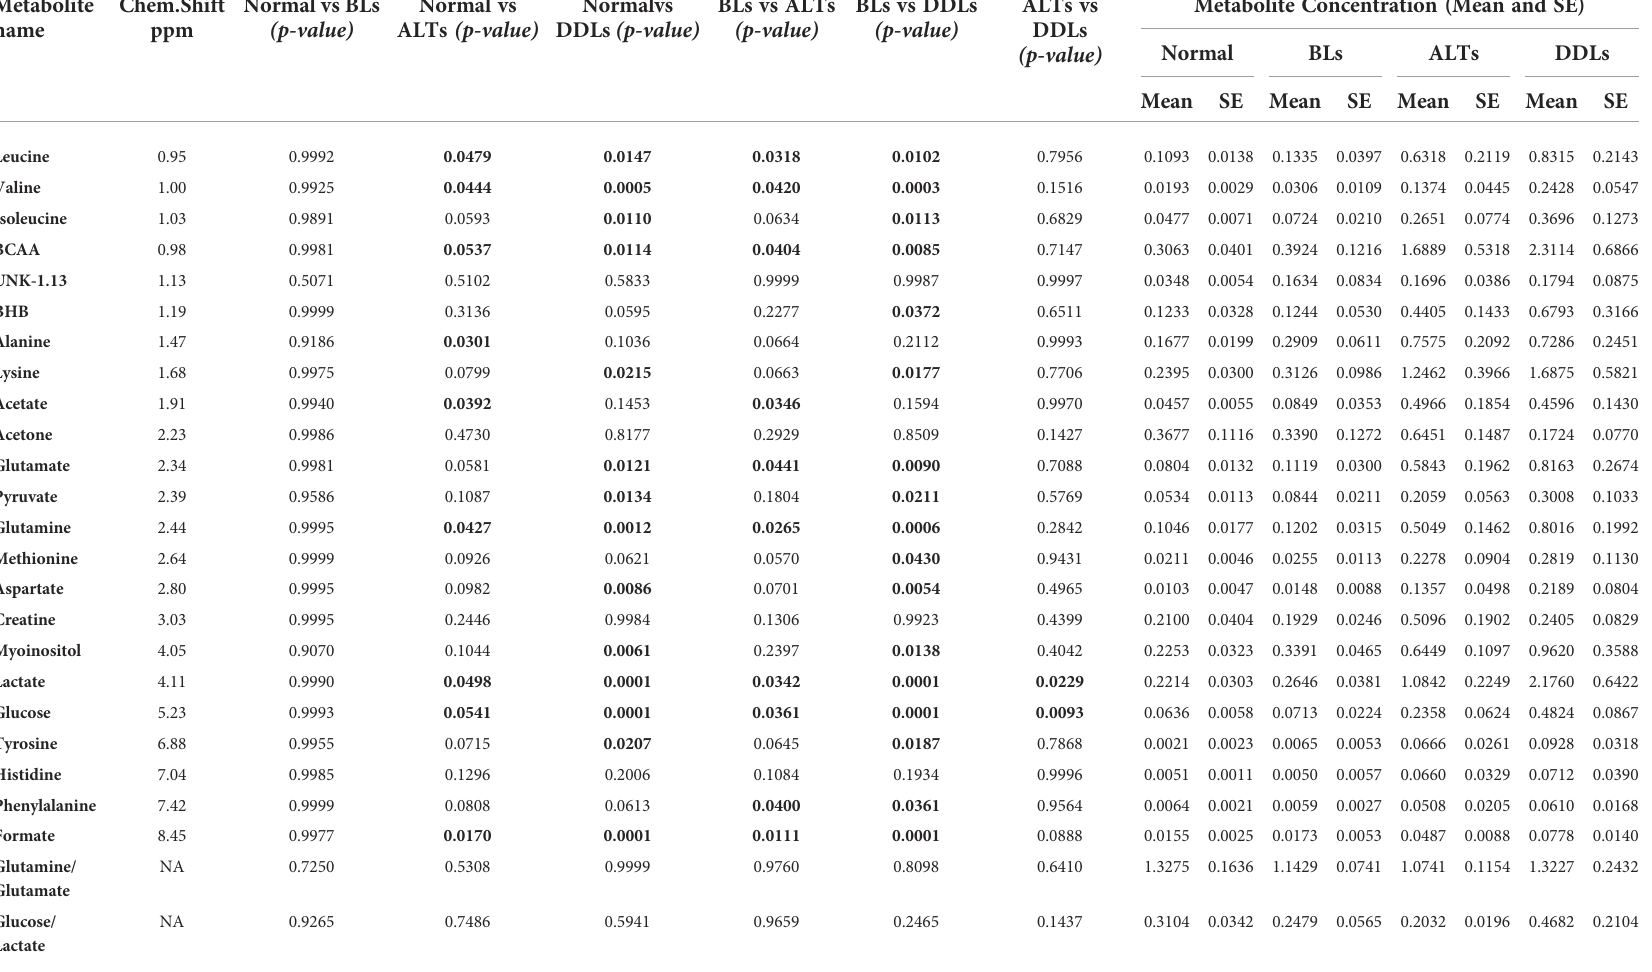
TABLE 2 List of metabolites quanti fi ed from the aqueous-phase of normal fat (n = 9), benign lipoma (BLs, n=10), well-differentiated liposarcoma (ALTs/WDL, n=7), and malignant grade dedifferentiated liposarcoma (DDLs,